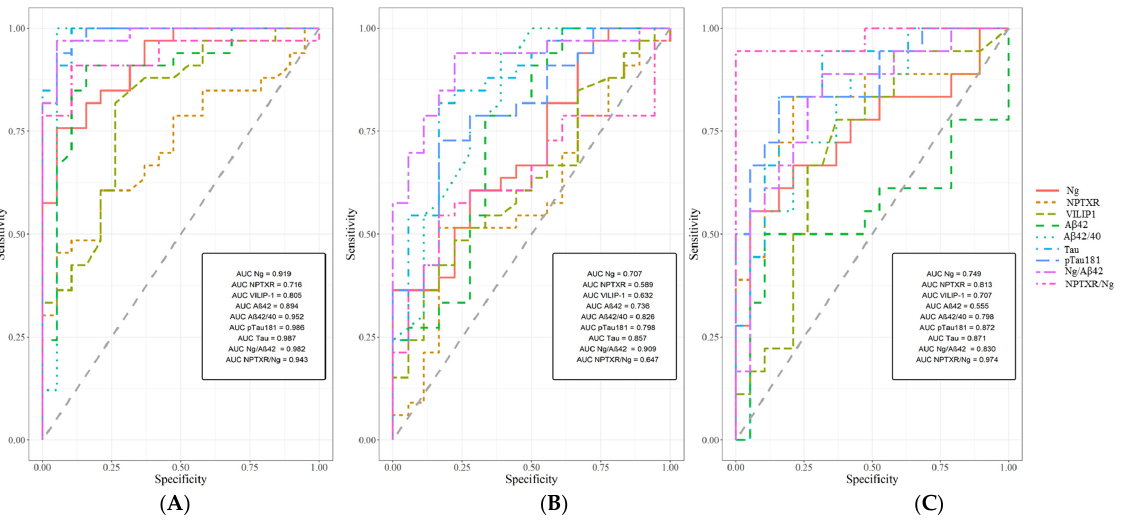
Figure 3. Areas under ROC curves (AUC) for CSF Ng, NPTXR, VILIP-1, A β 42/Ng, Ng/NPTXR, and classical biomarkers in ( A ) AD compared to CTRL; ( B ) AD compared to MCI; ( C ) MCI compared to CTRL. Ng—neurogranin, NPTXR—neuronal pentraxin receptor, VILIP-1—Visinin-like protein 1,